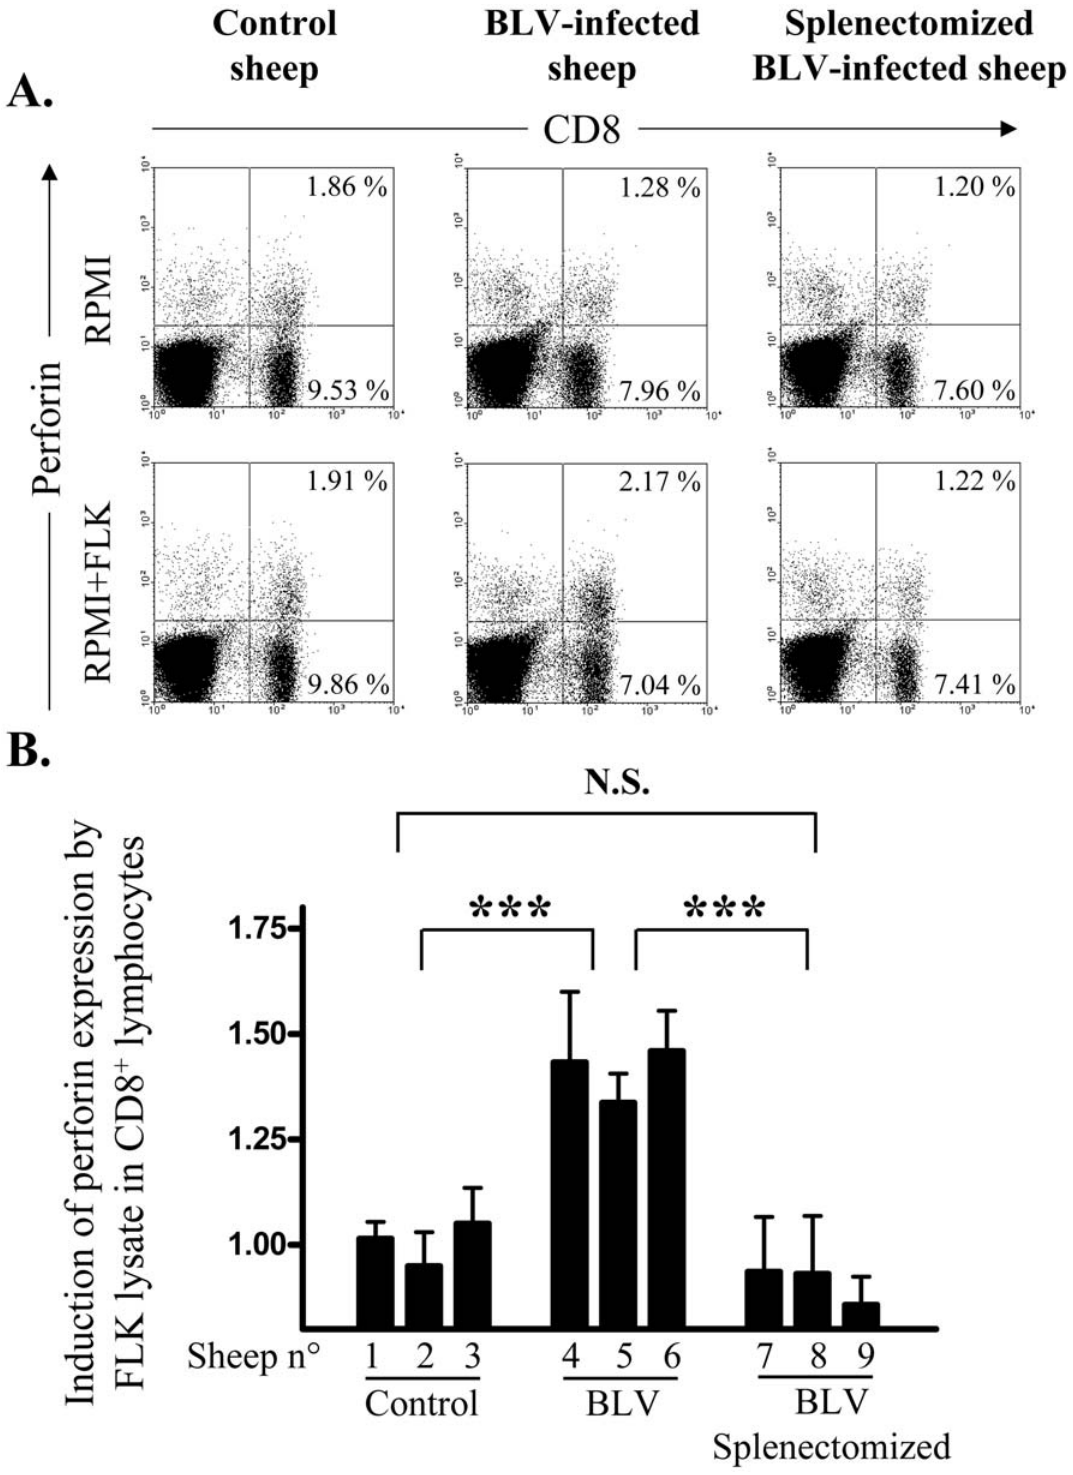
Figure 4. Induction of perforin expression in CD8 lymphocytes. Heparinized blood was incubated in RPMI medium in presence or absence of a lysate from FLK-BLV cells. After 5 days of culture, brefeldin A was added during 4 hours, leukocytes were permeabilized and CD8 and perforin expression were quantified by flow cytometry. (A) Representative dot plots of CD8 (x axis) and perforin (y axis) labeling of leukocytes from control, infected and splenectomized infected sheep, with and without antigenic stimulation. (B) Induction of perforin expression calculated as the ratio between the proportion of CD8 expressing perforin with and without antigenic stimulation. These values were measured 4 times (during a 3 months period) in control, BLV-infected and splenectomized BLV-infected sheep. Statistical relevance (N.S. not significant; *** very highly statistically significant p , 0.001) was calculated according to the unpaired two-tailed student t test with Welch’s correction.